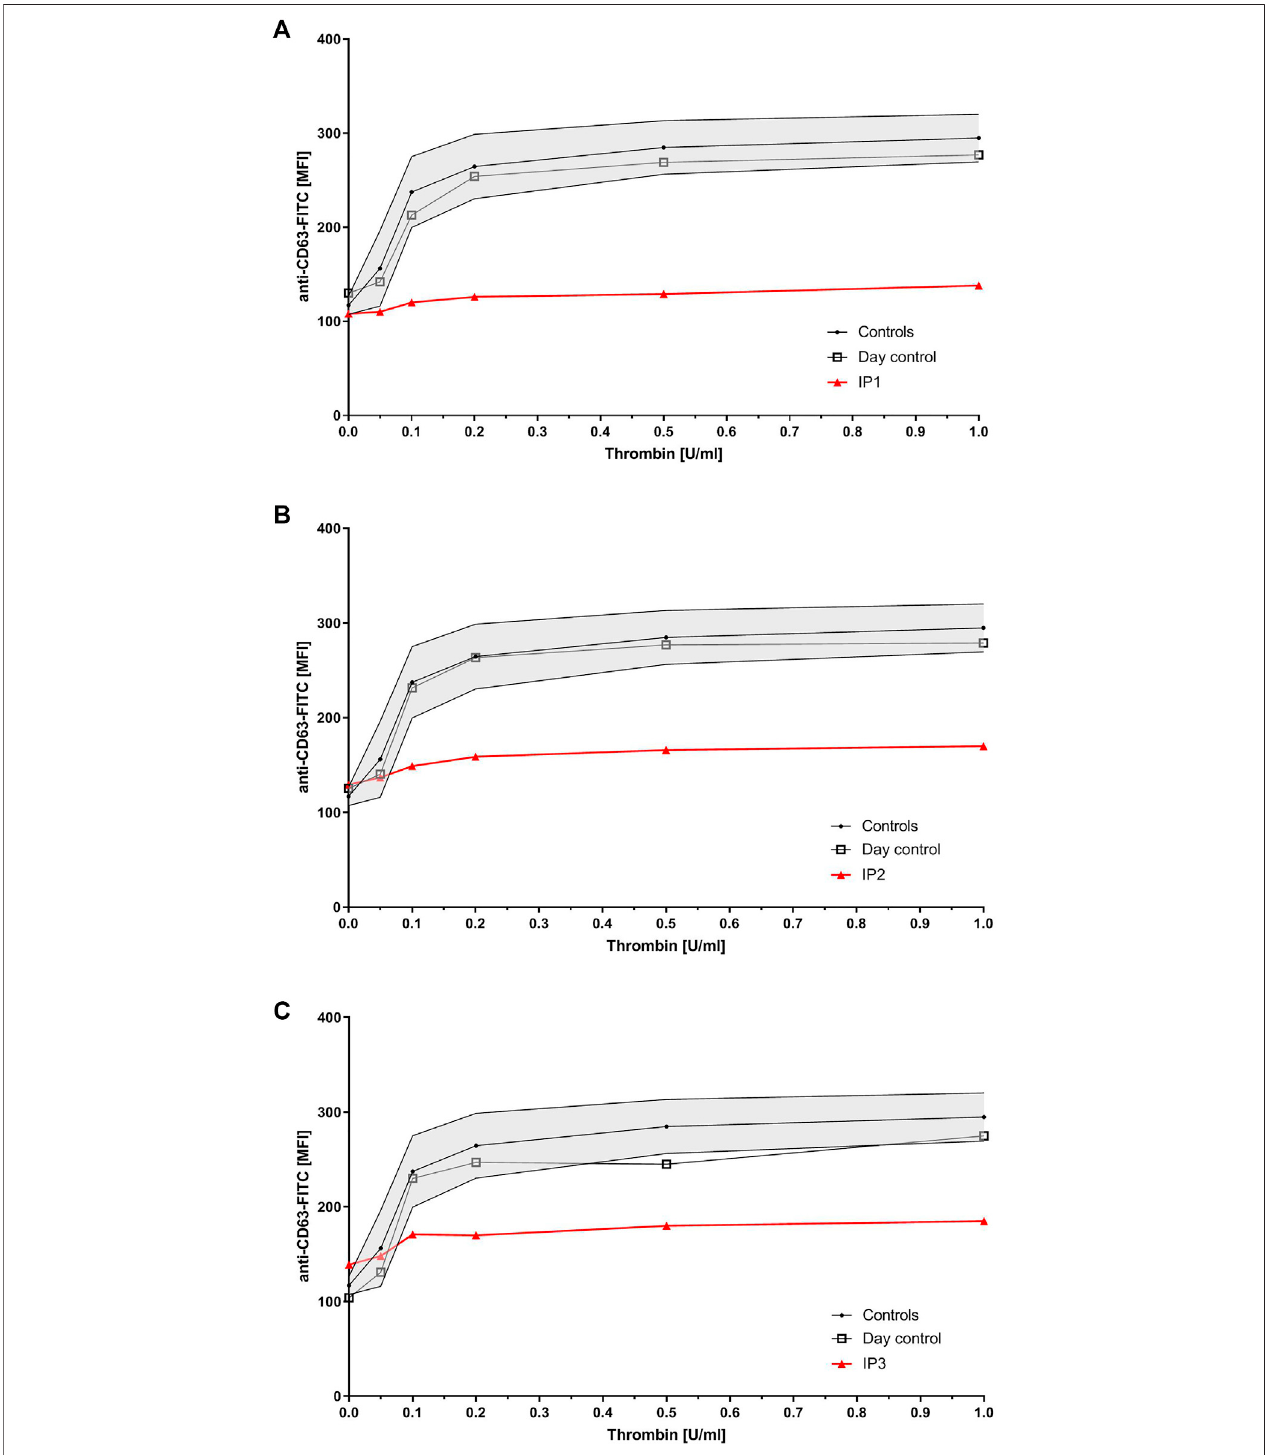
FIGURE 1 | Platelet granule secretion stimulated with thrombin (concentrations: 0, 0.05, 0.1, 0.2, 0.5, and 1.0 U/ml) for all three index patients using fl ow cytometry. Severely impaired δ -granule secretion indicated by reduced platelet CD63 expression in IP1 (A) , IP2 (B) , and IP3 (C) compared to the healthy controls/day control. Data are expressed as logarithmic arbitrary units (logAU) of anti-CD63-stained unstimulated and thrombin-stimulated platelets.